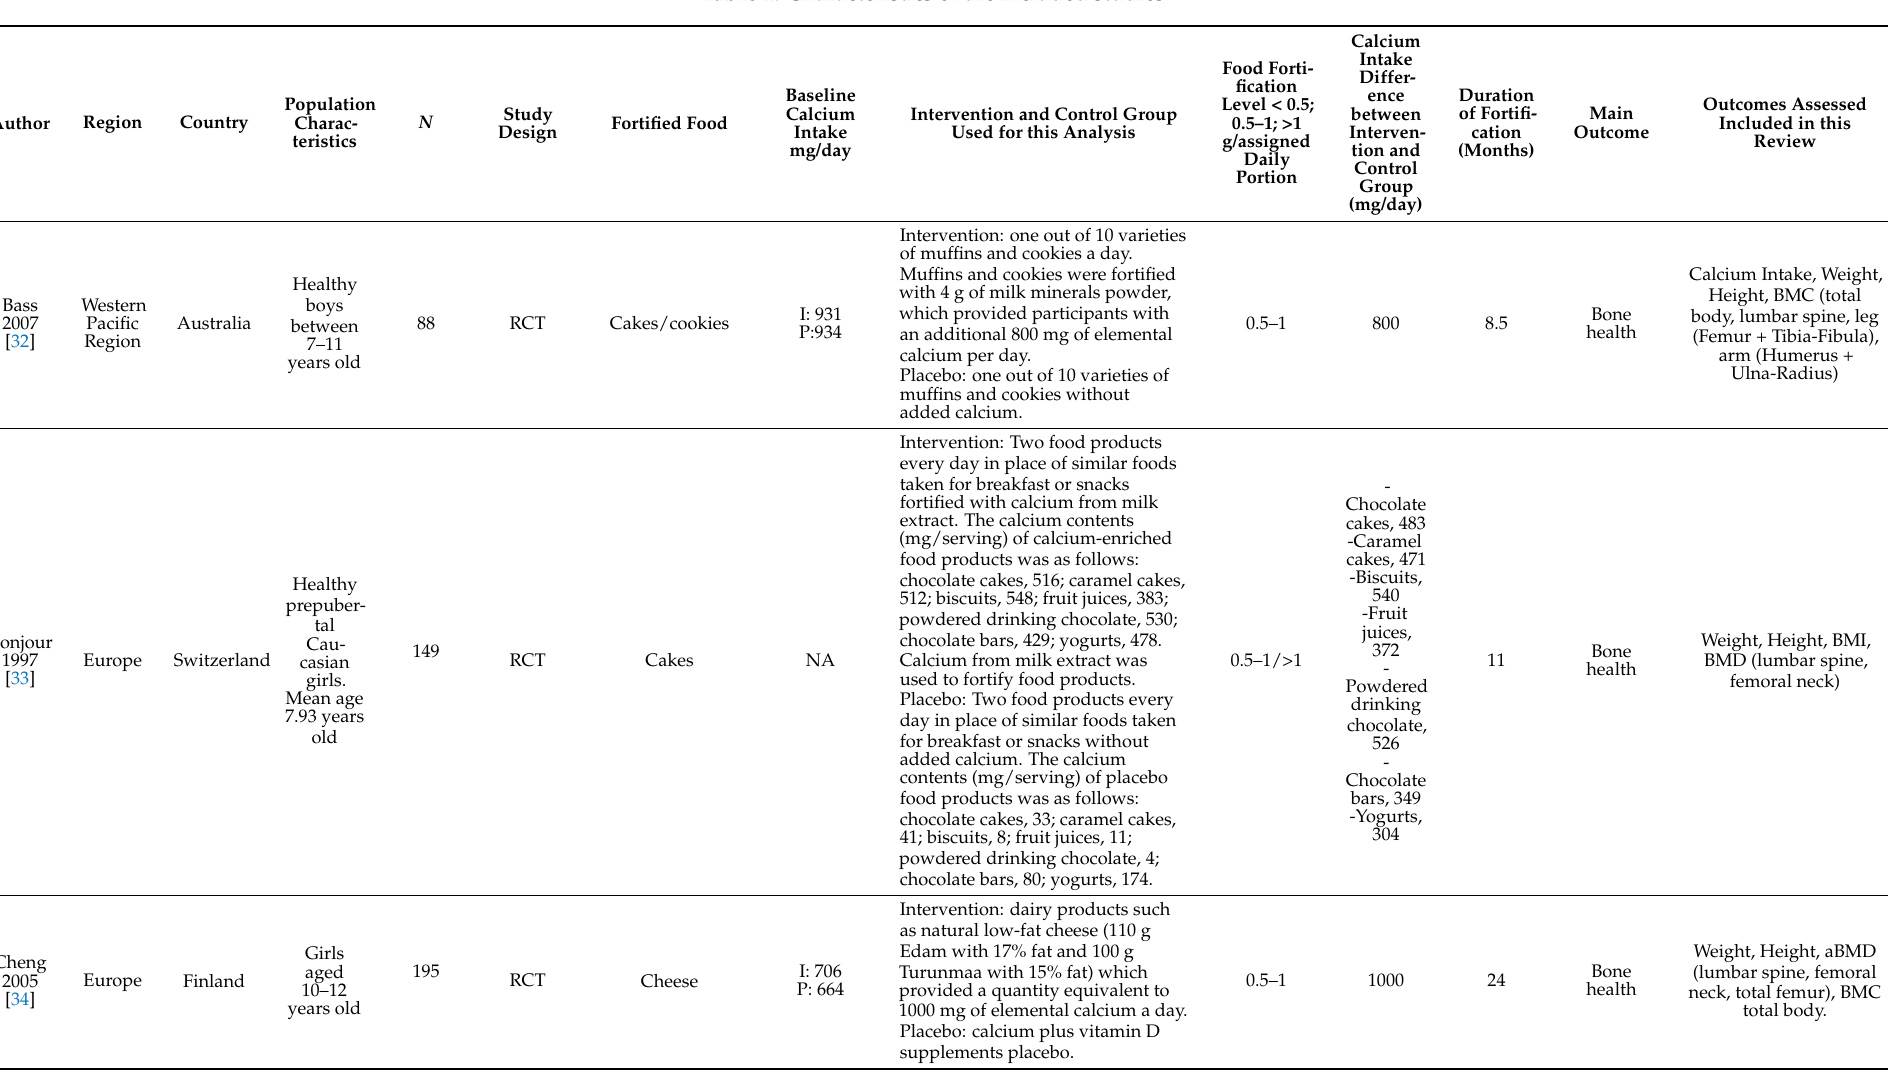
Table 1. Characteristics of the included